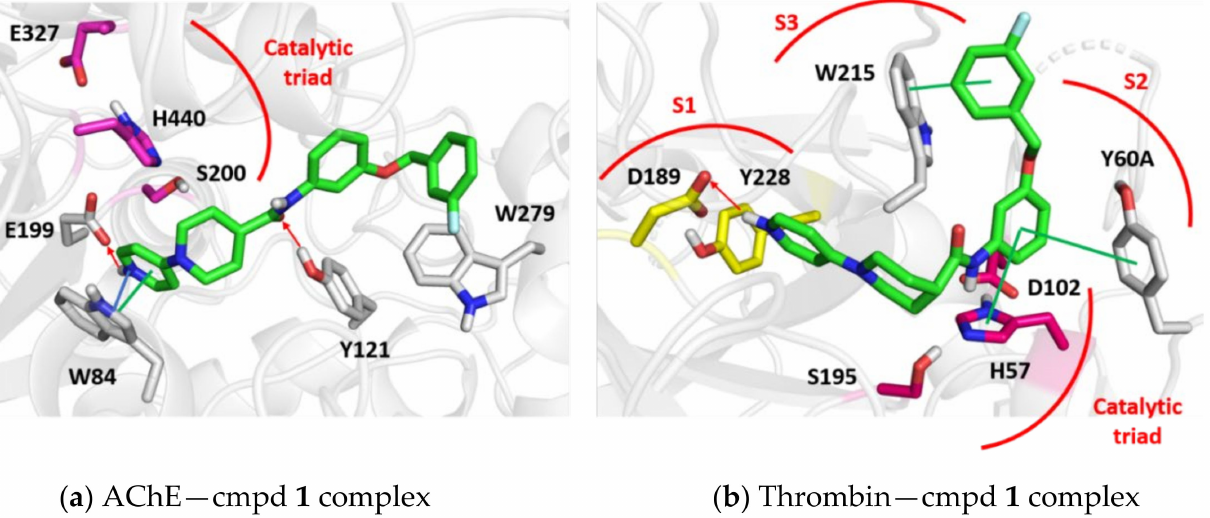
Figure 2. Top-scored docking poses of cmpd 1 vs. AChE ( T. Californica , PDB_ID: 1EVE) and vs. thr ( H. Sapiens , PDB_ID: 1UVS) are shown on the left and right hand-side, respectively. The protein is shown in ribbon, and the ligands and potentially interacting residues are shown in stick format. Catalytic triads are colored in magenta. Green and blue lines report π – π and cation– π interactions. Red arrows indicate hydrogen bonds. Pockets S1, S2 and S3 in the thr binding site are flagged in red. Docking score values are equal to − 8.613 and − 8.718 kcal/mol for 1 vs. AChE and thr,